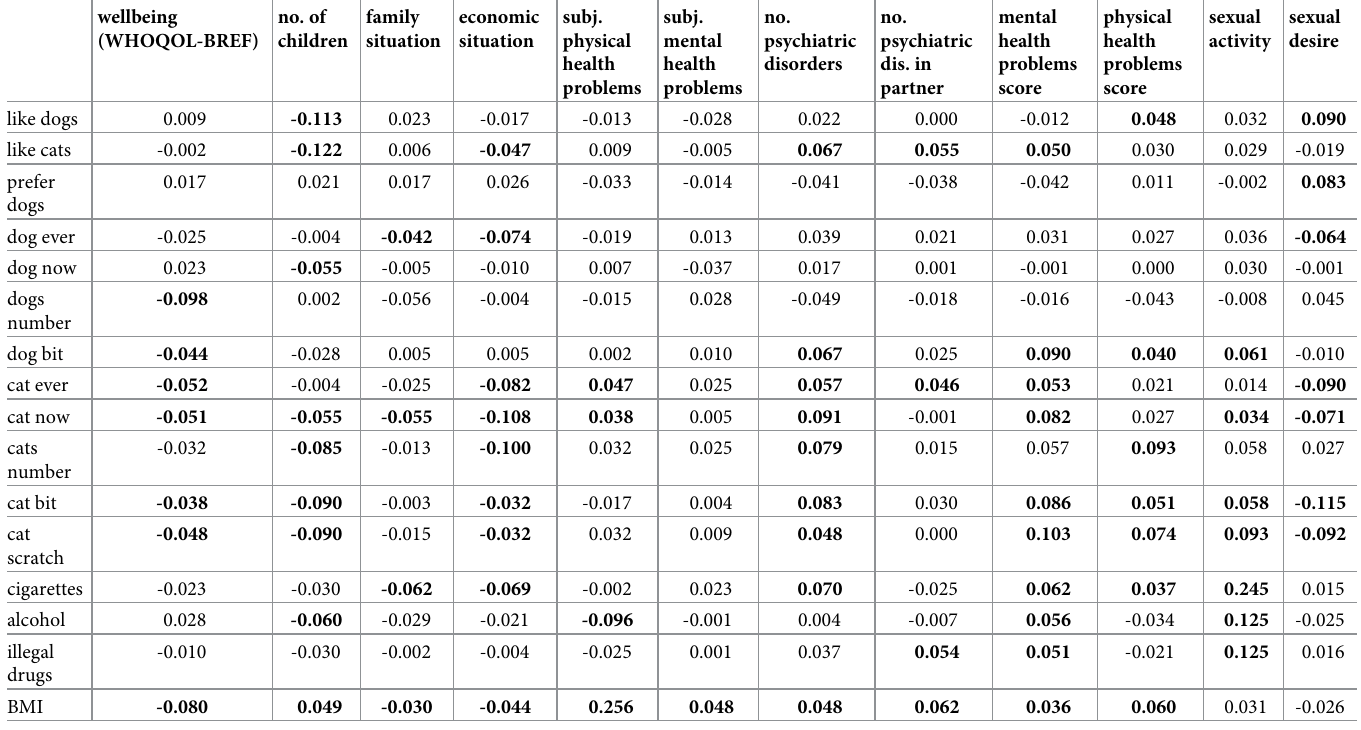
Table 7. Association of animals-related variables with wellbeing and health of Toxoplasma -free female responders. wellbeing no. of family economic (WHOQOL-BREF) children situation